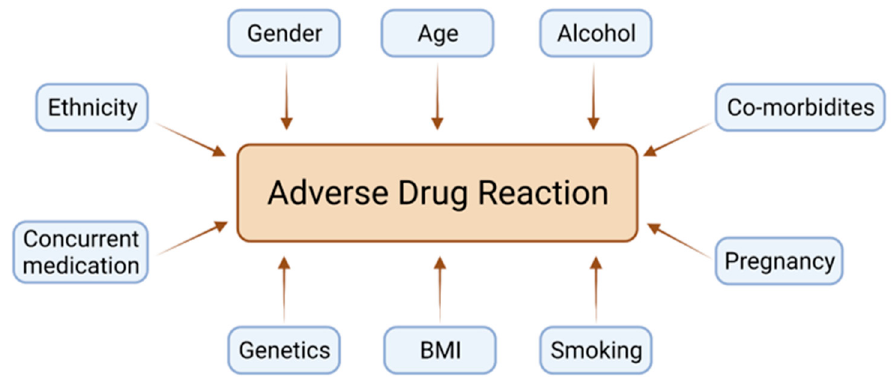
Figure 1. Contributing factors to an adverse drug reaction.